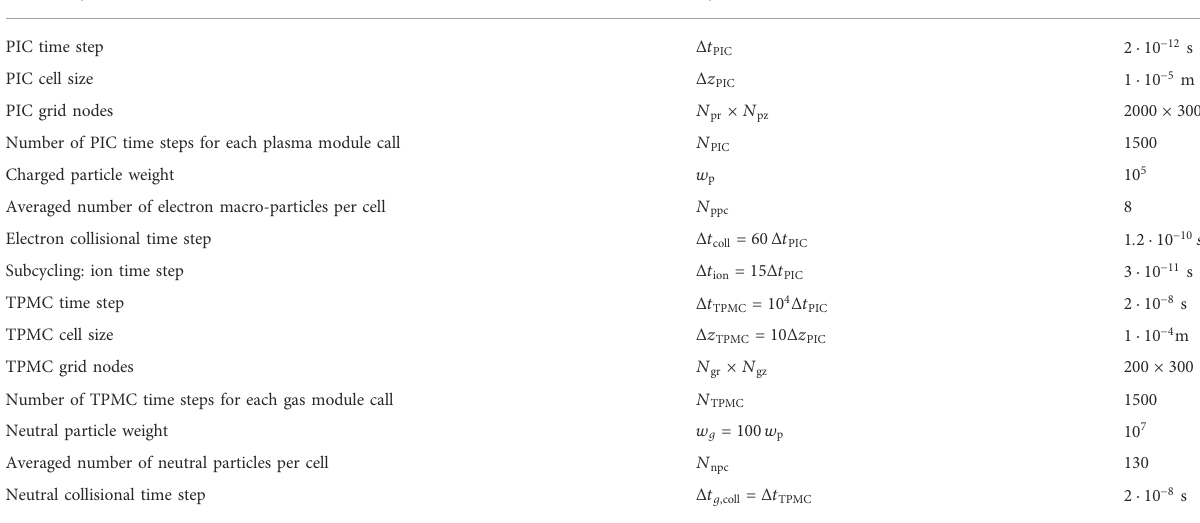
TABLE 1 Simulation parameters used for the present PIC-DSMC